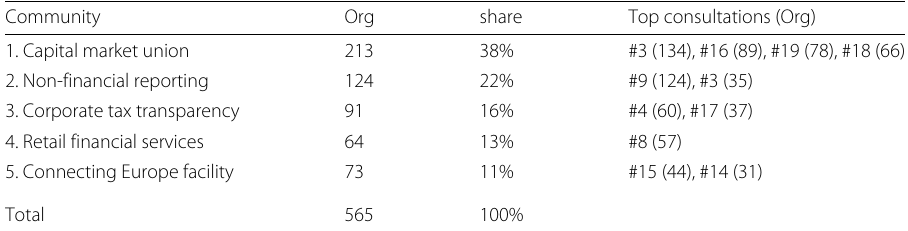
Table 3 Detected topic communities of the lobby organizations, their number and share in each community, and top consultations which received the most responses (the number of responding organizations is in